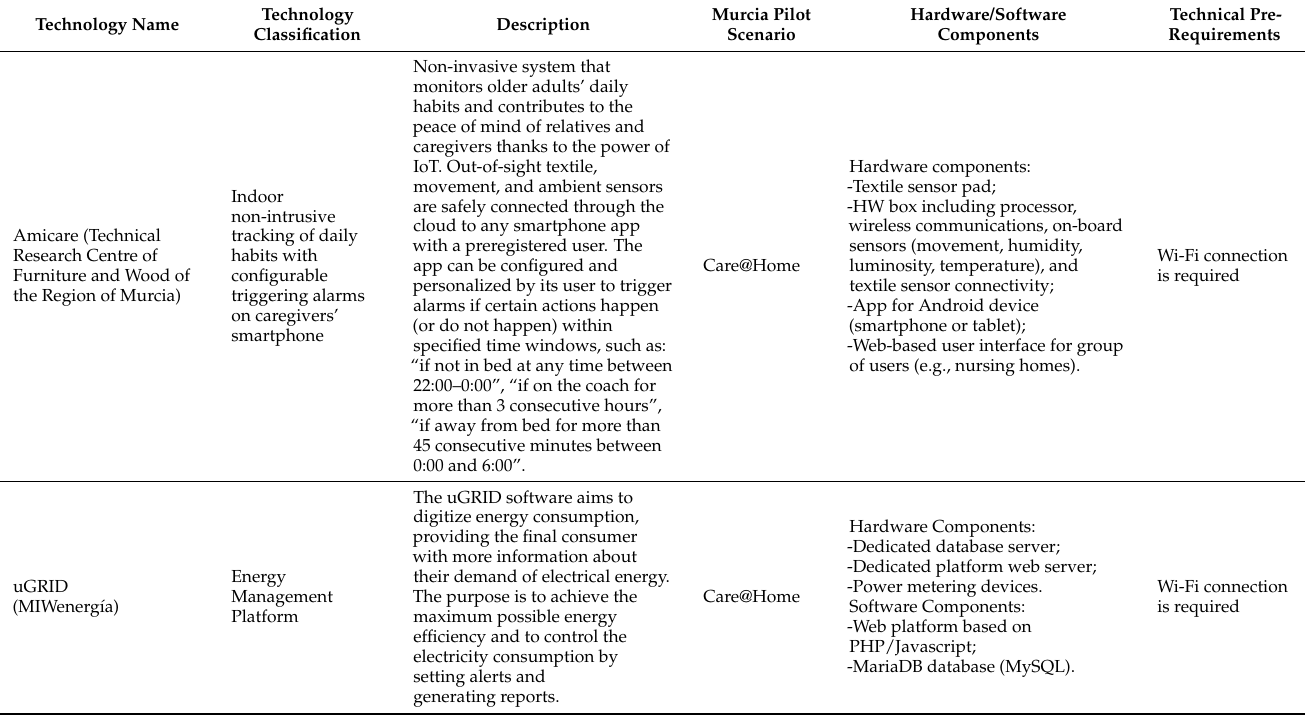
Table 1. Technologies of the Pharaon Murcia